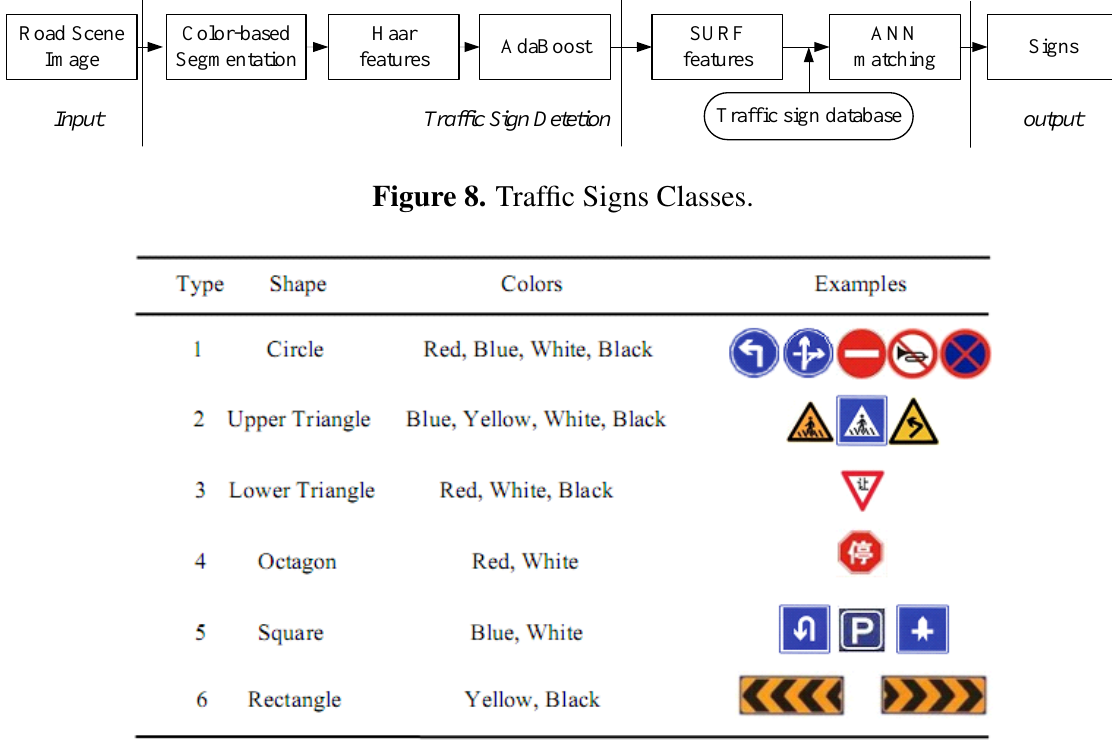
Figure 7. Flow chart of traffic signs recognition system.